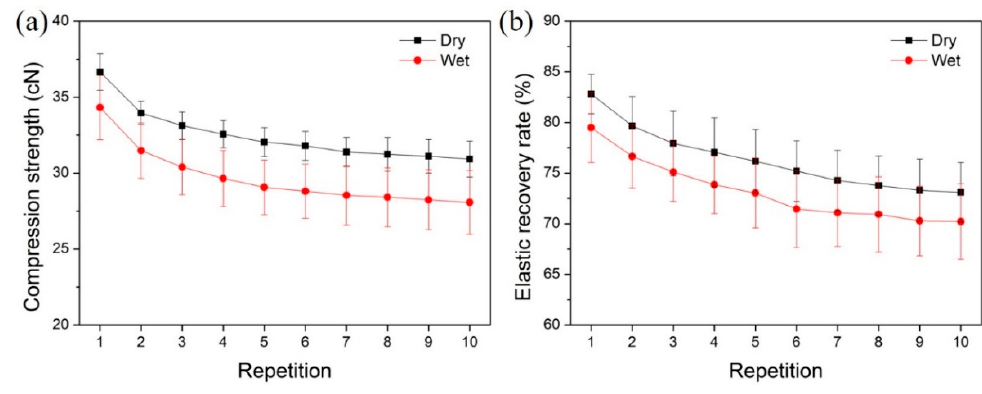
Figure 9. Influence of repetition on ( a ) compression strength and ( b ) elastic recovery rate of textile pile debridement materials in dry and wet